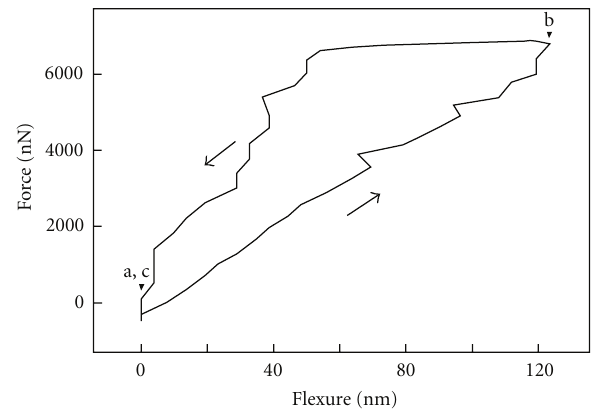
Figure 4: Force-flexure curve of C 70 nanotube during bending shown in Figure 3. Points a–c correspond to the states shown in Figures 3(a)–3(c), respectively. The arrows indicate the time path of recording.